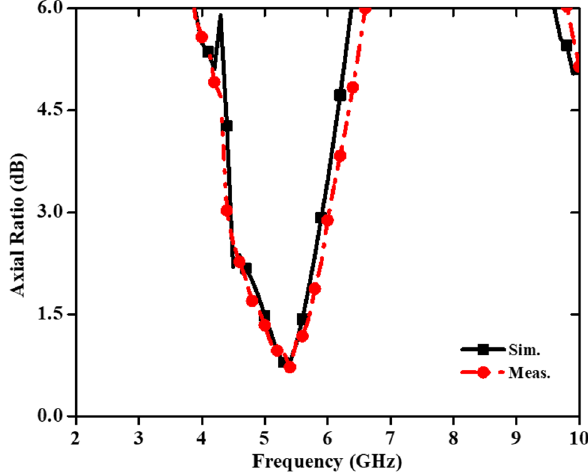
Figure 20. Axial ratio of CP-based MIMO antenna [71].